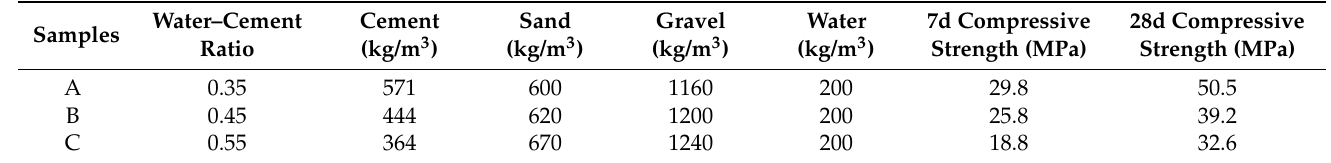
Table 2. Mix proportions and mechanical